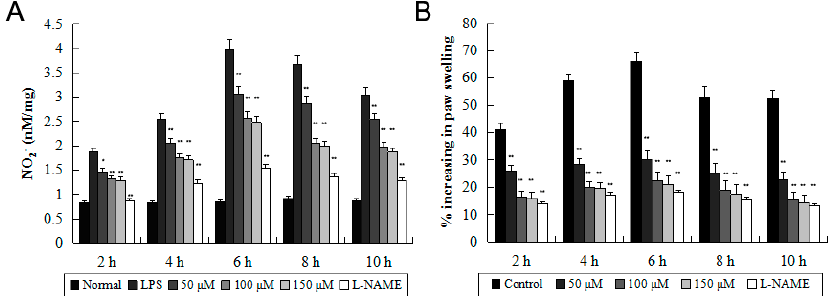
Figure 5. Effect of nano-TiO 2 on carrageenan-induced paw edema. 0.1ml of nano-TiO 2 (50–100 μ M) was administered 1 h before carrageenan stimulation. ( A ) NO 2 − in the footpad was detected using the Griess method; ( B ) The degree of swelling in the footpads was measured using a plethysmometer. Data were shown as means ± SD of three independent experiments. * p < 0.05 against control group; ** p < 0.01 against control group.